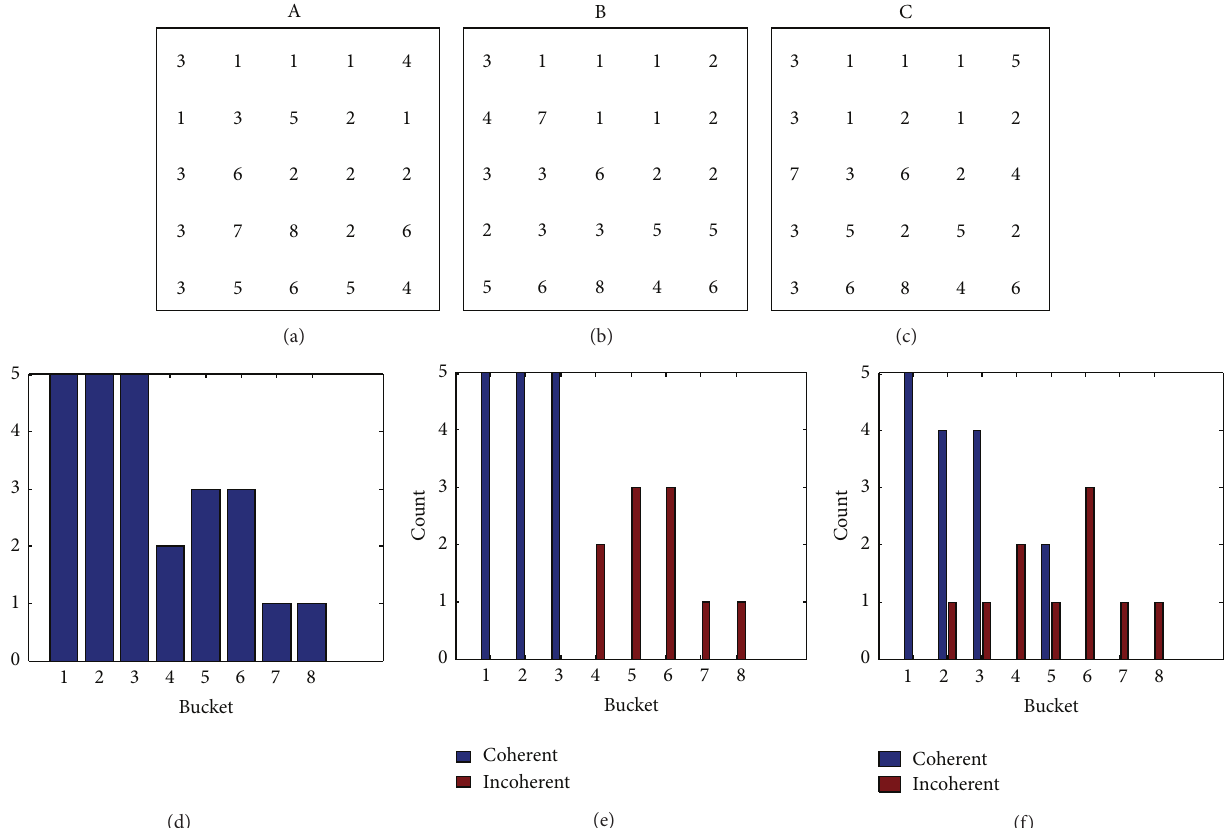
Figure1:CentroiddistancematricesandtheirDH,DCVhistogramof3images.(a)CentroiddistancematrixofimageA;(b)centroiddistance matrix of image B; (c) centroid distance matrix of image C; (d) DH of images A, B, and C; (e) DCV histogram of images A and C; (f) DCV histogram of image B.